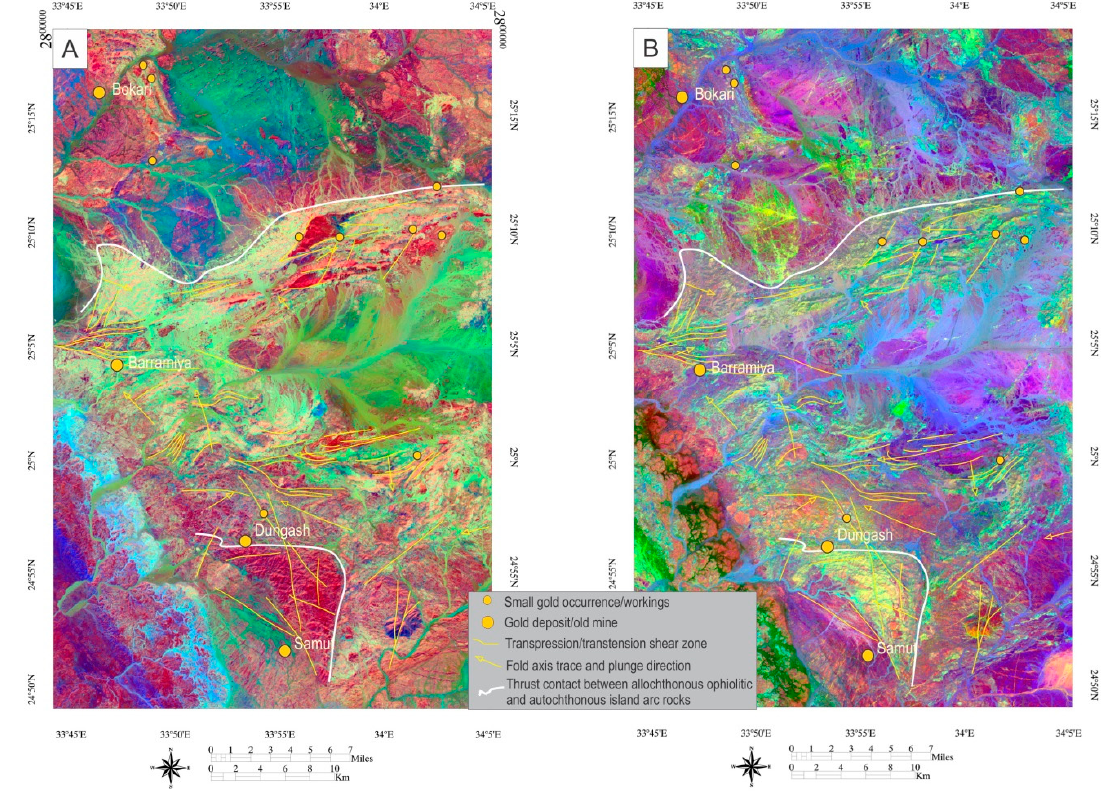
Figure 5. False-color composite, Sentinel-2 PCA images for the study area: ( A ) PC1, PC2, and PC3 in R, G, and B channels, respectively. Notice the island arc metavolcanic/metavolcaniclastic rocks are conspicuously distinctive as reddish color pixels. The light color domains within the ophiolitic mélange terranes are those experienced high strain and demarcating transpression. The boundary between ophiolites and island arc rocks appears prominent and fold trajectories are easy to trace, ( B ) PC6, PC5, and PC4 in R, G, and B channels, respectively. Iron oxide/hydroxide minerals (red pixels), Al–OH and Fe, Mg–OH-bearing and CO 3 alteration minerals (green pixels) and ferrous silicates mineral groups (blue pixels). The yellow lines refer to the main structural elements (faults, thrusts, and shear zones), while the yellow arrows are traces of the fold axial planes and the arrowhead point towards the plunge direction.